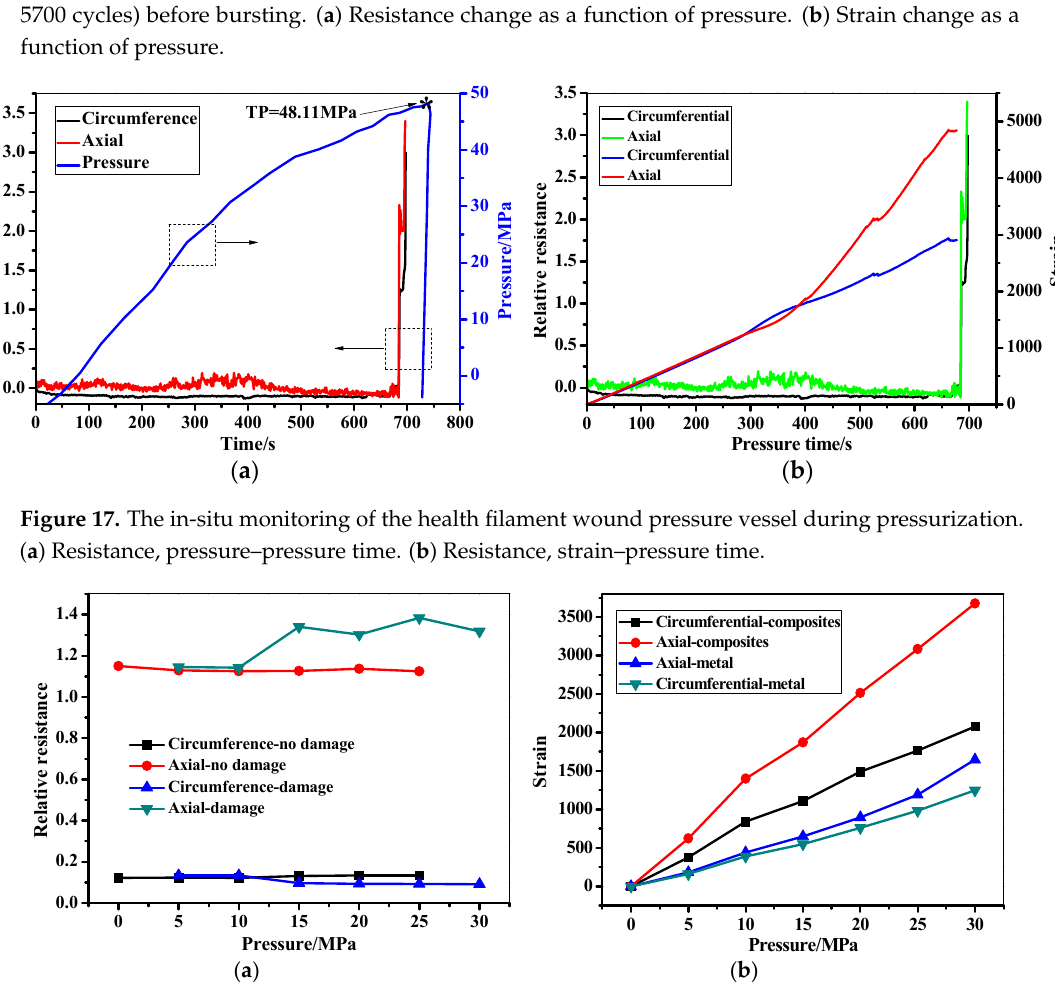
Figure 16. The in-situ monitoring of the filament wound pressure vessel (after hydraulic fatigue for